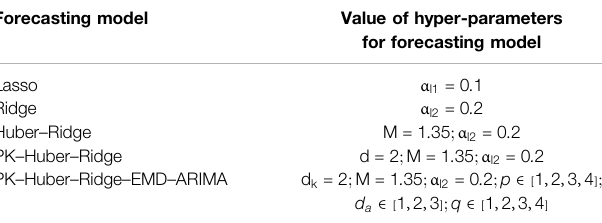
TABLE 5 | Value of hyper-parameters for fi ve different models. Forecasting model